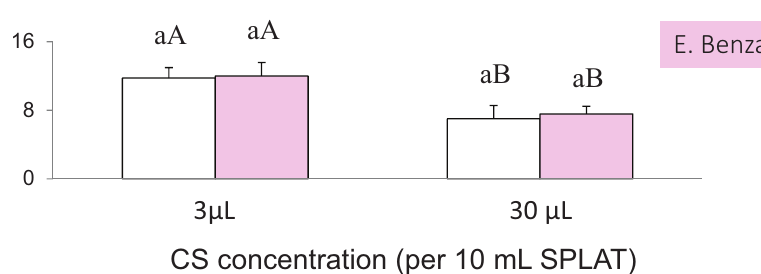
(cid:4) = 0.05) (Figure 4E). The response pattern observed in the learning test followed that of the innate response test in that the psyllids probed less frequently into the 30 μL concentration than into the 3 μL concentration ( t = 3.634, p < 0.001, (cid:4) =